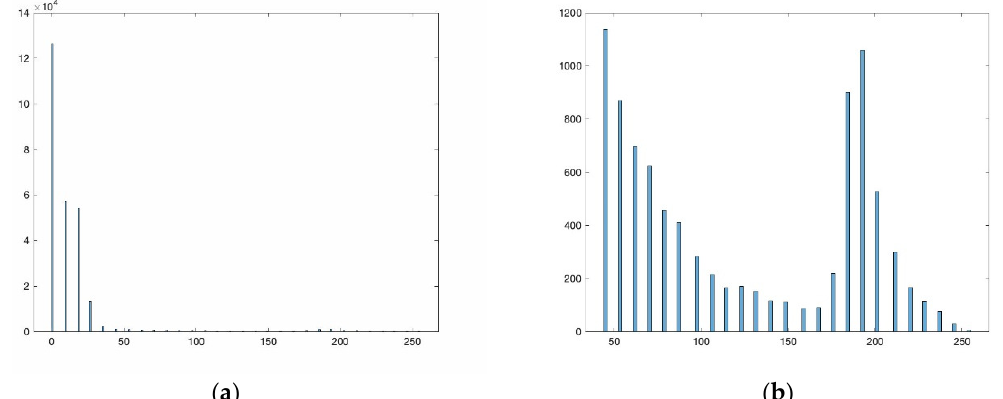
Figure 8. CT image histogram of a wheat spike. ( a ) The complete histogram; ( b ) the histogram between 50 and 255